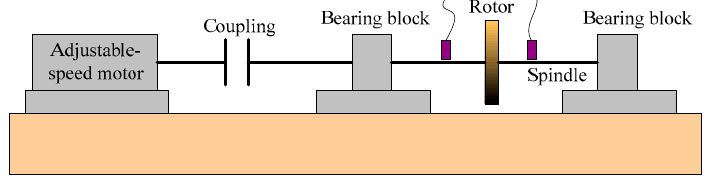
Figure 17. Schematic diagram of the rotor test bench.